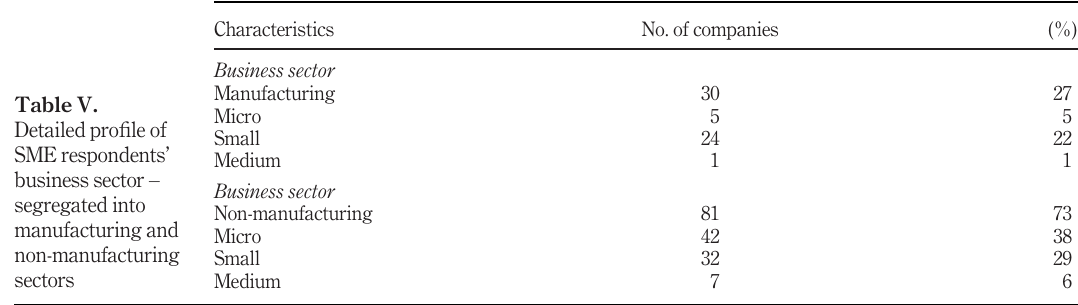
Characteristics